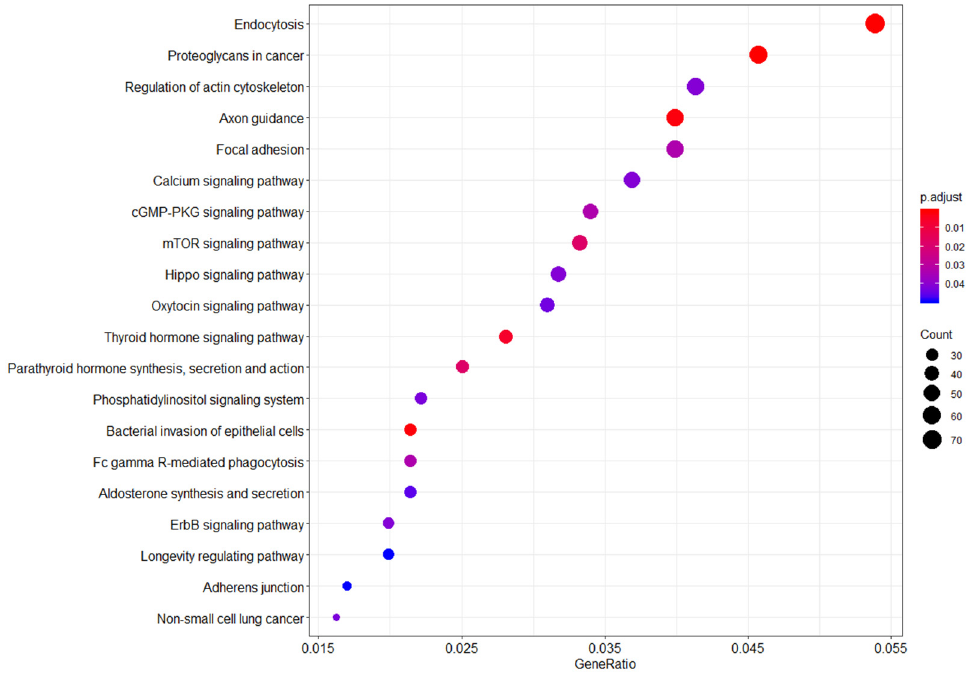
Figure 2. Functional genomic pathways enriched in the WTC-exposed (WTC EHC) breast cancer cases vs. WTC-exposed cancer-free women. Legend: Summary of pathway network analysis highlights the relationship between probe sets enriched in the WTC-exposed women compared to unexposed women. Y-axis shows the probe sets with significant overlap with the reference probe sets/genes from the KEGG database. X-axis shows the ratio of the number of differentially expressed probe sets/genes to the total number of genes included in the particular pathway gene set from the reference KEGG pathway database. The dot sizes are proportional to the number of overlapping probe sets/genes. The dot colors show the p ‐ value adjusted for false discovery rate.